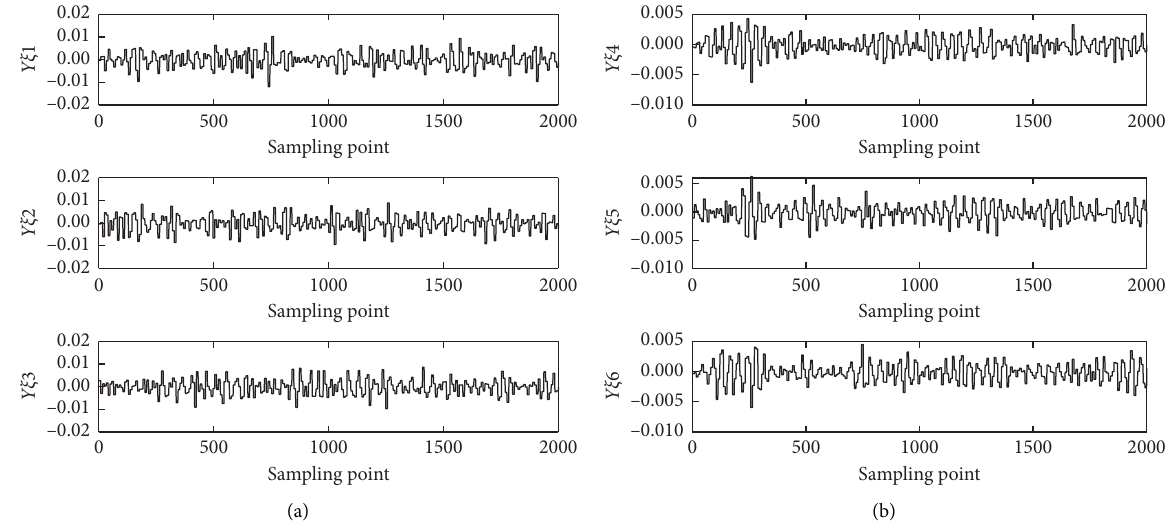
Figure 9: Estimated upstream and downstream leakage signals diagram: (a) upstream no. 1 sensor leakage noise reduction signal diagram and (b) downstream no. 2 sensor leakage noise reduction signal diagram. Table 1: Two-two correlation coefficient between separated signals. Correlation coefficient Y ζ